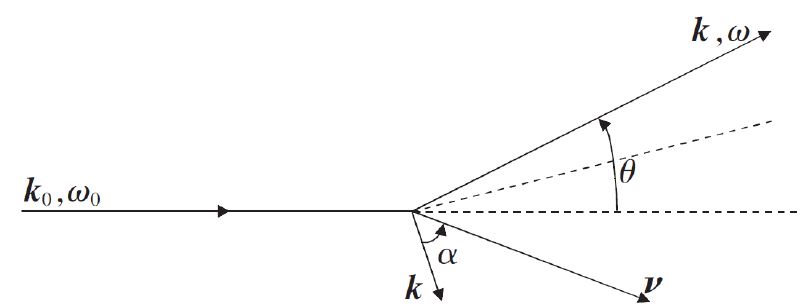
Figure 1. Laser Doppler frequency shift caused by moving object (Where k 0 is incident light vector, k is scattering light vector, v is particle velocity vector, ω 0 is the frequency of incident light, ω is the frequency of scattered light, and θ is the phase).